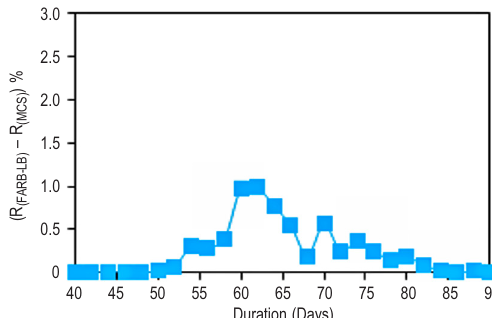
Fig. 4. Difference between reliability of project completion time produced by FARB and Monte Carlo simulation